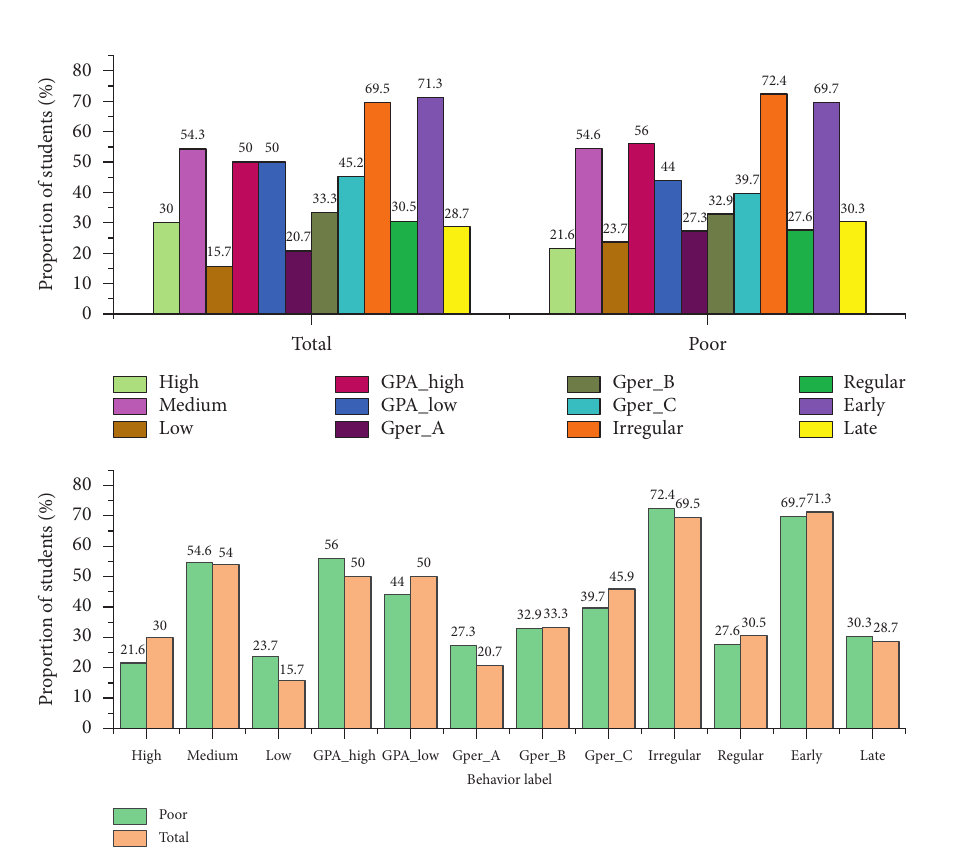
Figure 3: Label proportion and changing